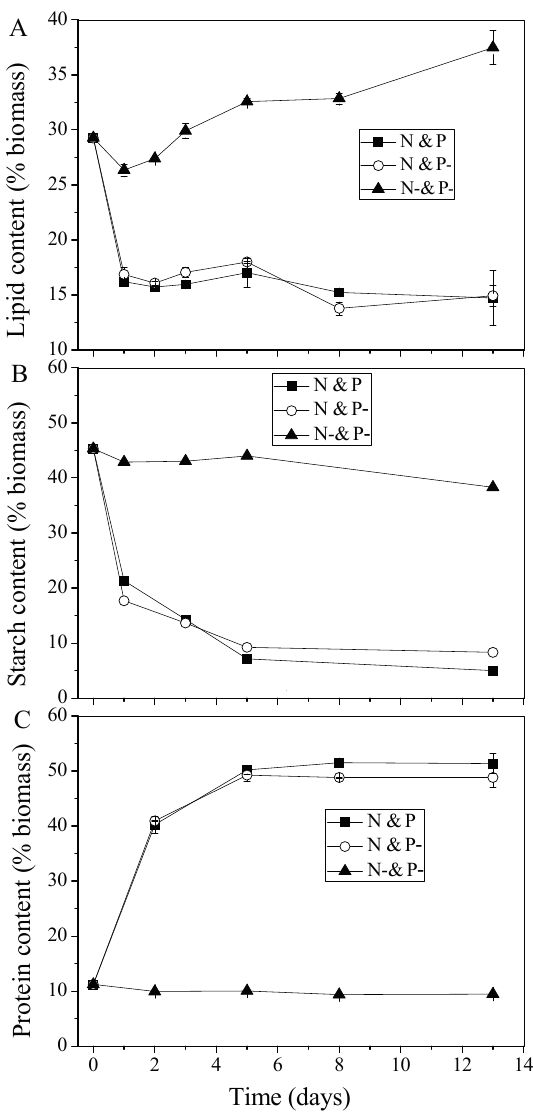
Figure 3. Storage products of C. vulgaris grown in different media. ( A ) lipid; ( B ) starch; and ( C ) protein. Values shown are averages of two samples ±